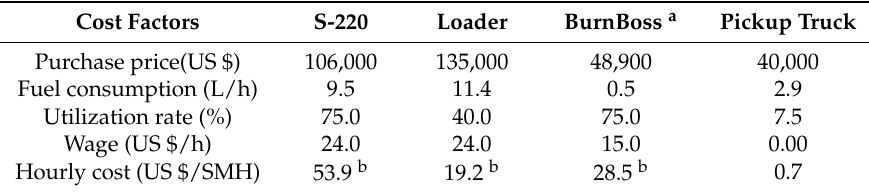
Table 2. Summary of input values and assumptions used to estimate hourly machine cost of S-220 and BurnBoss systems test in this study. The S-220 system include a loader while the BurnBoss oeprations were loaded by hand. Cost Factors S-220